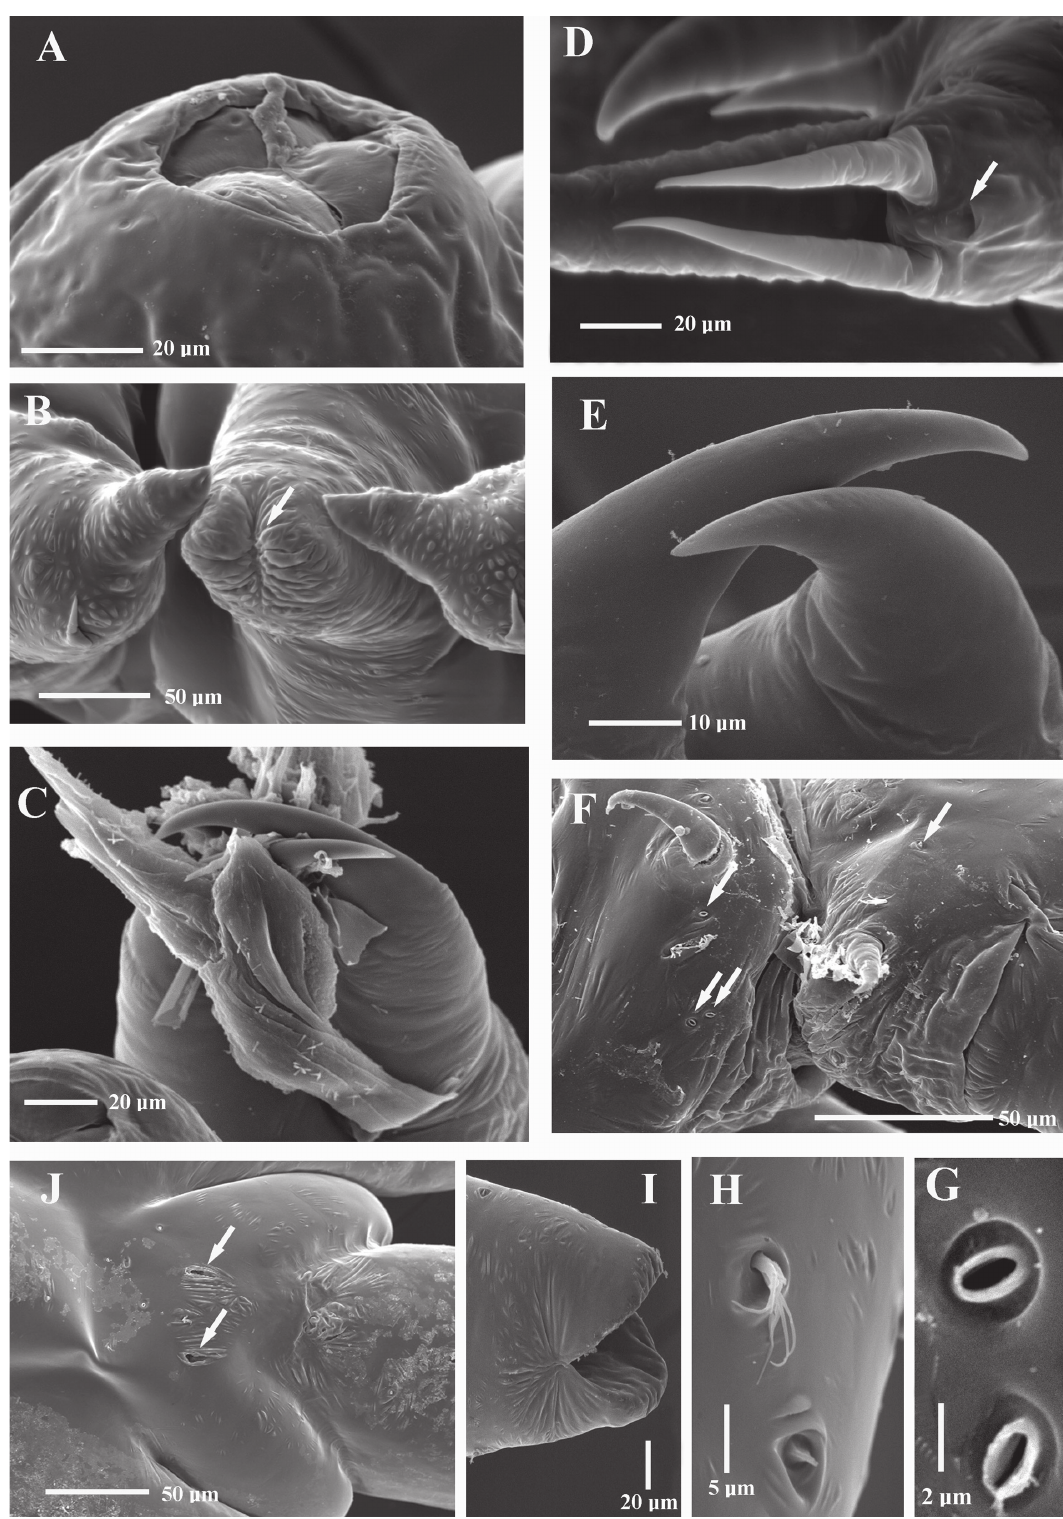
Fig . 6. – larvae of Ammothea glacialis (Hodgson, 1907). sEM photograph: a, mouth, second instar larva; b, anus, third instar larva; C, attachment to the cohesive ball, third instar larva; D, pore on second walking leg, fourth instar larva; E, fingers of chelifore, internal surface, second instar larva; F, pores on outer lateral surfaces of chela bases and on dorsolateral-distal surface of basal segment (lateral-distal of cheli- fore basal segment lacks spinning apparatus), third instar larva; G, detail from F showing the pores; H, multifurcated sensillum, fourth instar larva; I, anus, fourth instar larva; J, pores in the centre of the rudiments of the fourth walking legs, fourth instar